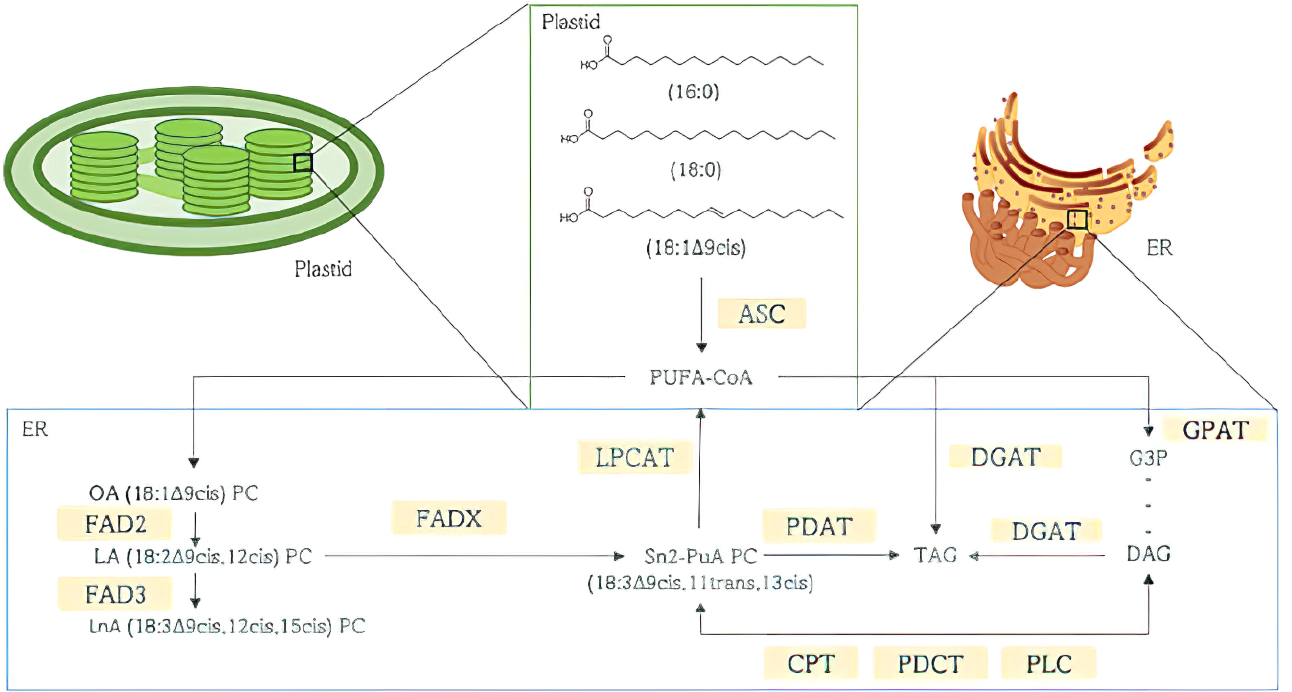
Figure 4. Punicic acid (PuA) biosynthesis and storage in triacylglycerol (TAG). Phosphatidylcholine (PC), Oleic acid (OA), Linoleic acid (LA), position sn2 Punicic Acid (PuA), Punicic Acid Phosphatidylcholine (Sn2-PuA PC), Fatty Acid Desaturase (FAD) 2 and FADXs, acyl-Coenzyme A (CoA), Acyl-CoA synthetase (ACS), Triacylglycerol (TAG) Phospholipid:diacylglycerol Acyltransferase (PDAT), Lysophosphatidylcholine Acyltransferase (LPCAT), n-glycerol-3-phosphate acyltransferase (GPAT), diacylglycerol acyltransferase (DGAT), sn-glycerol-3-phosphate (G3P), sn1,2-diacylglycerol (DAG), CDP-choline:1,2-diacyl-sn-glycerol cholinephosphotransferase (CPT), phosphatidylcholine: diacylglycerol cholinephosphotransferase (PDCT), phospholipase C (PLC).